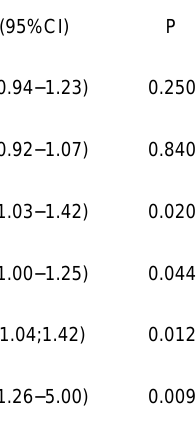
* Data from the Generalized Poisson mixed adjusted for baseline values; a Generalized linear models adjusted for baseline value were used for between-groups difference (95% CI) at 6 months; mHealth = mobile health; UCT = usual care treatment.